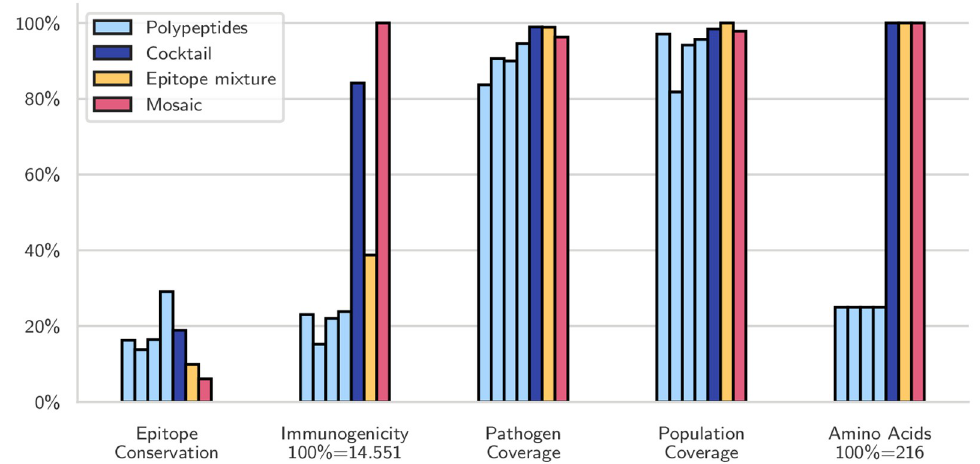
Fig 5. Cocktail of mosaic proteins compared to an equivalent string-of-beads vaccine. We designed a cocktail (blue) of four polypeptides (cyan) that covers 99% of the pathogens, even though the single fragments only cover between 85 and 95%. The orange and red bars correspond to an epitope mixture designed by OptiTope and a mosaic with the same number of amino acids respectively; the former was required to reach 99% pathogen coverage, and the latter was